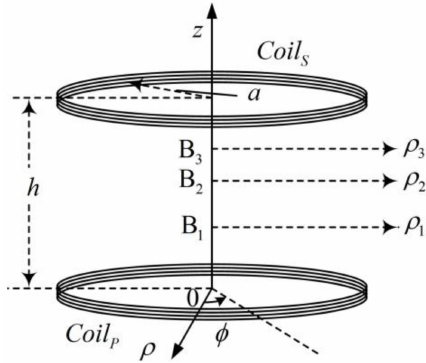
Figure 9. The three points are located in the z -axis.